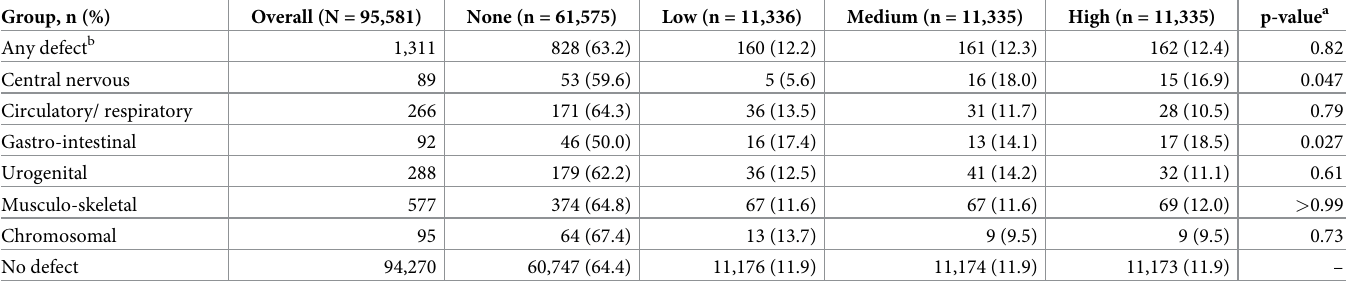
Table 2. Birth defect outcomes by level of exposure to active mountain-top removal mining within five kilometers of maternal residence. Group, n